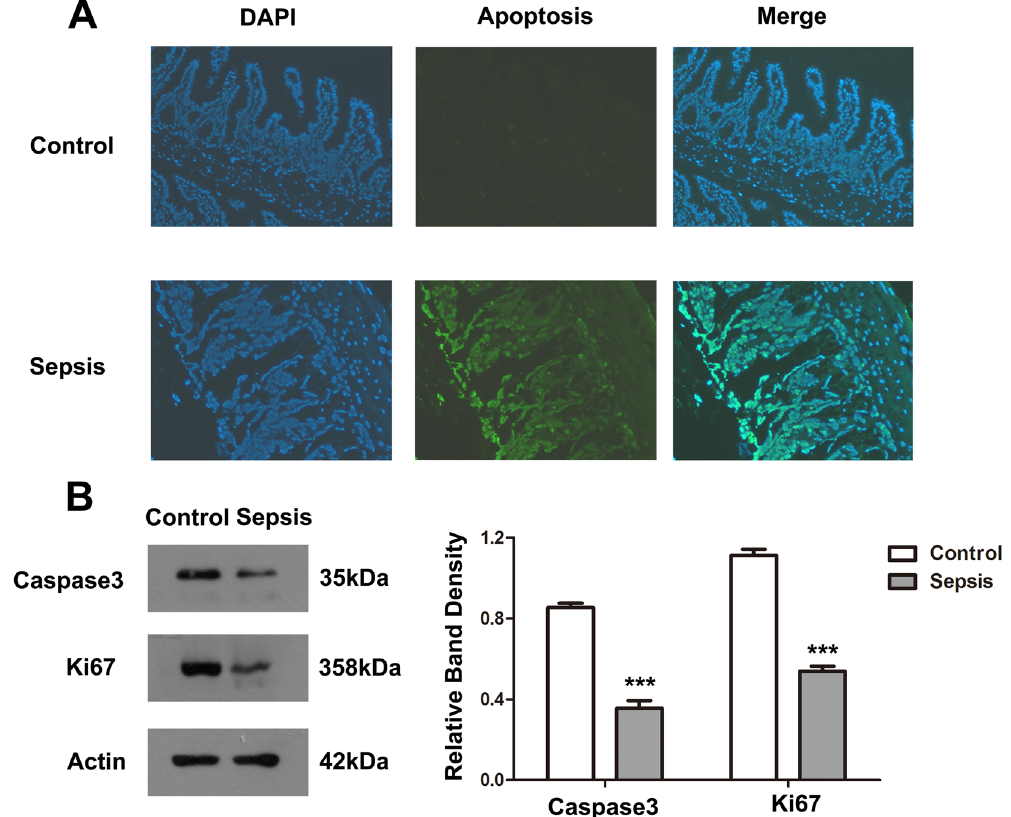
Figure 2. Sepsis suppresses intestinal epithelial-cell proliferation and induces apoptosis. ( A ) TUNEL assay was used to determine apoptosis in intestinal epithelium. The green-stained (fluorescein isothiocyanate (FITC)) cells are apoptotic cells. ( B ) Intestinal tissue protein of each group was extracted, and western blot was used to determine the levels of Ki67 and caspase3. Actin was used as control. The graph represents the relative band densities. Values are mean ± SEM (n = 3). *** P < 0.001 versus control